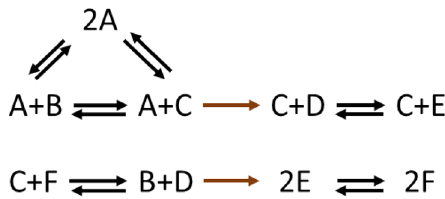
Figure 4. A nonstoichiometric BC in a toy network. The conversion diagram depicts a network with m = 6 species, n = 9 complexes, and r = 8 reactions. The network has one balanced complex ( 2 A ) which is a type-I nonstoichiometric BC. As predicted by Proposition 3, the two irreversible reactions in this network (highlighted in brown) are both blocked at steady